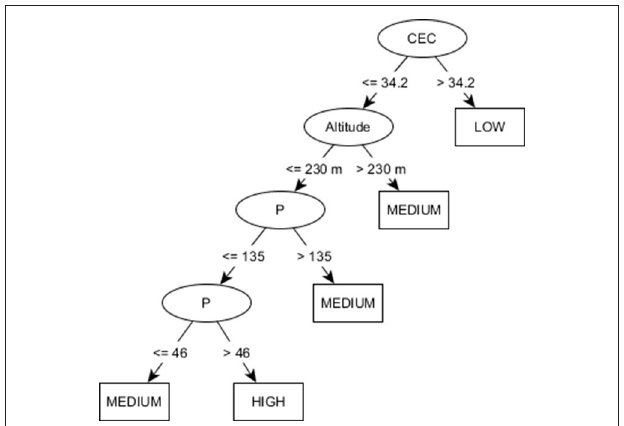
FIGURE 4 | Data mining classification tree for prediction of primary productivity in a field.